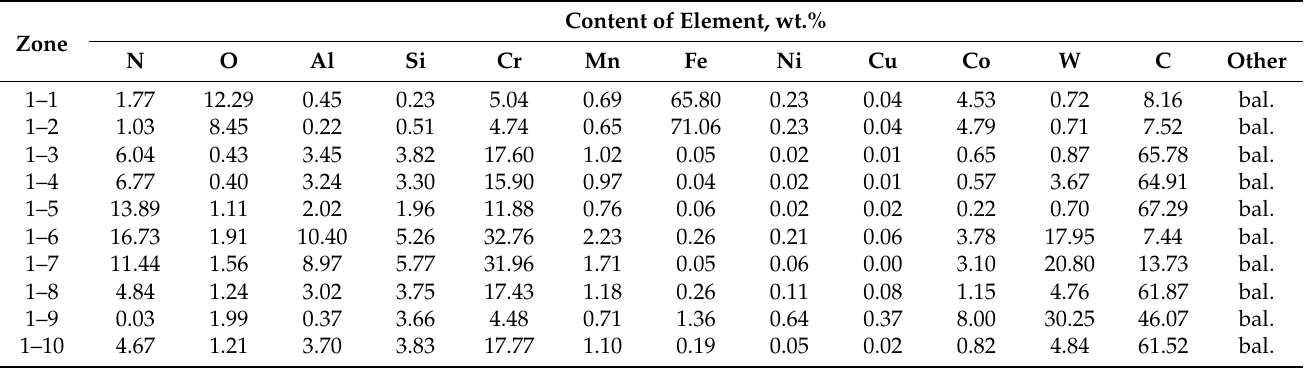
Figure 3. Image of the sample surface in area 1 at the boundary of the friction track: ( a )—characteristic zones, ( b )—zones of X-ray spectral analysis, ( c )—maps of the distribution of chemical elements. Table 2. The chemical composition of the sample surface zones in area 1 (the edge of the friction track, the strip of wear products, and the coating outside the friction zone). Content of Element,